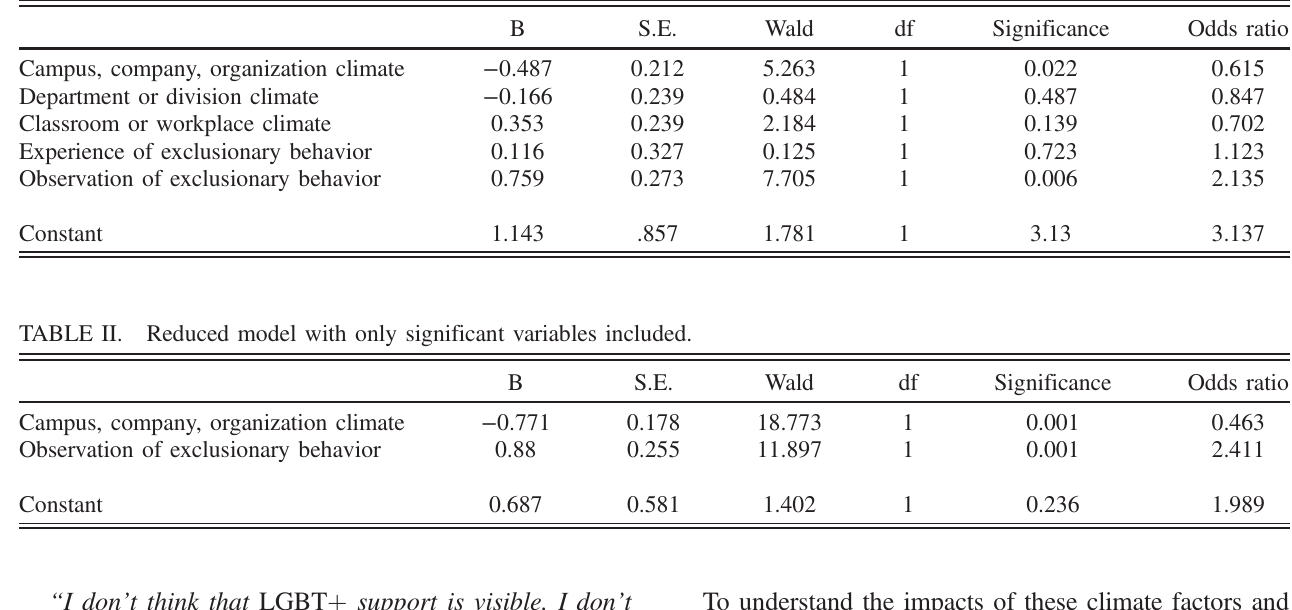
TABLE I. Impact of climate and observation of EB on consideration to leave.